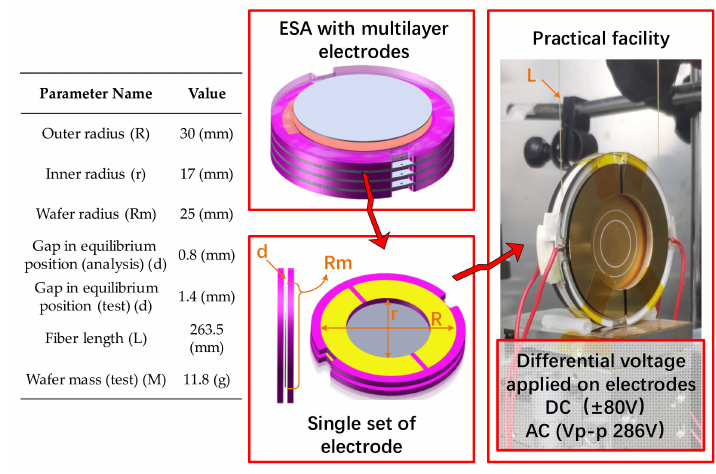
Figure 1. Structure parameters and the overview of the device for analysis. ESA adopts the capacitance technique for displacement detection and equips elec- trodes with different functions to control the test mass. The actuation electrode on a single side is separated into differential pairs to maintain the virtual ground potential of the proof mass [31]. Based on the arrangement of the electrodes, the capacitor model of ESA is shown in Figure 2.